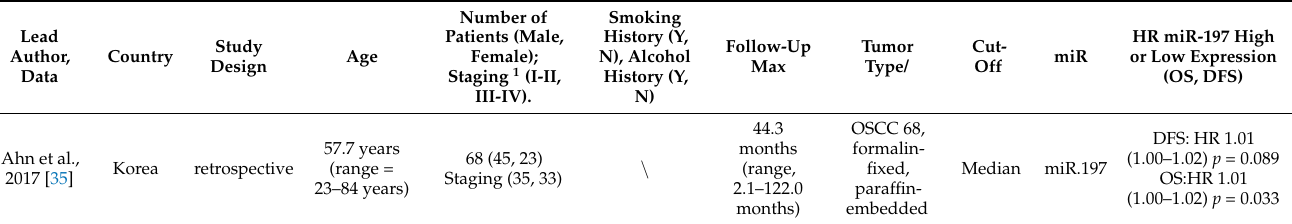
Table 1. The data extracted for the study included in the meta-analysis.